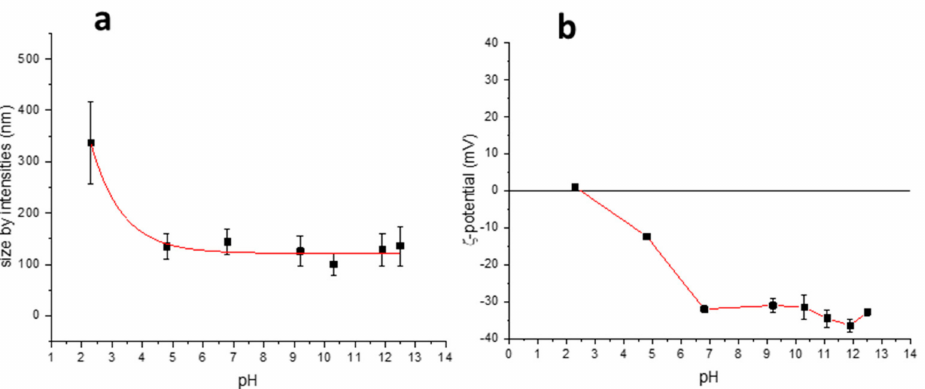
Figure 1. ( a ) Hydrodynamic diameters, and ( b ) ζ -potential as a function of pH, of the polymer BAC-EDDS in